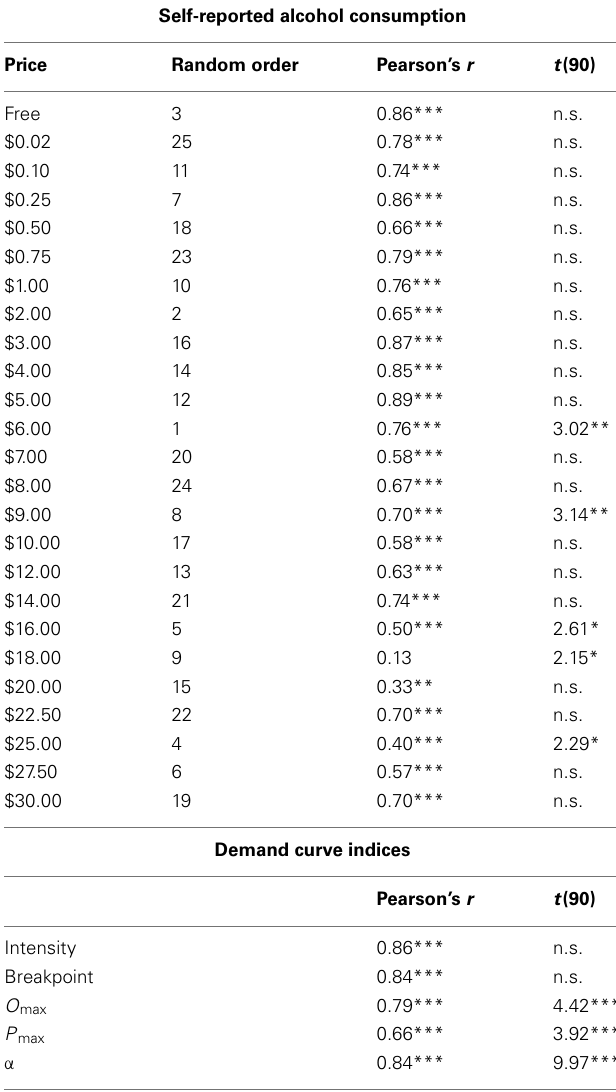
Table 1 | Comparison of sequential and randomized alcohol purchase